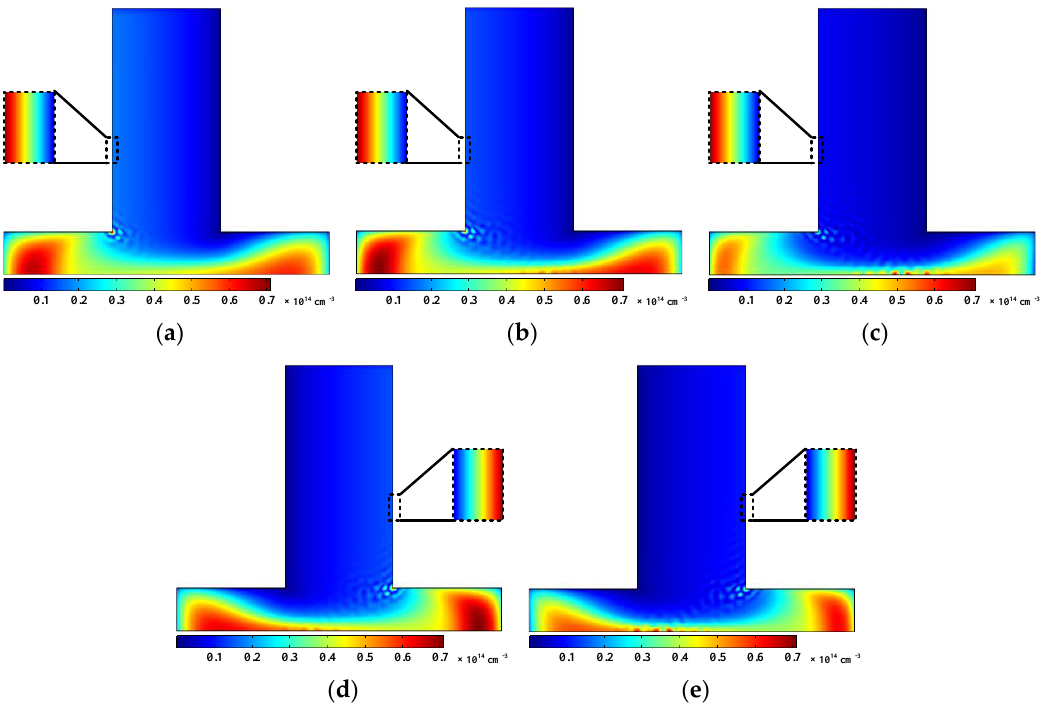
Figure 16. Spatial distribution of the O 2 density for times ( a ) 2 ms, ( b ) 6 ms, ( c ) 10 ms, ( d ) 14 ms, and ( e ) 18 ms for the reactor at AC 22 kV voltage and 1 cm distance between electrodes.